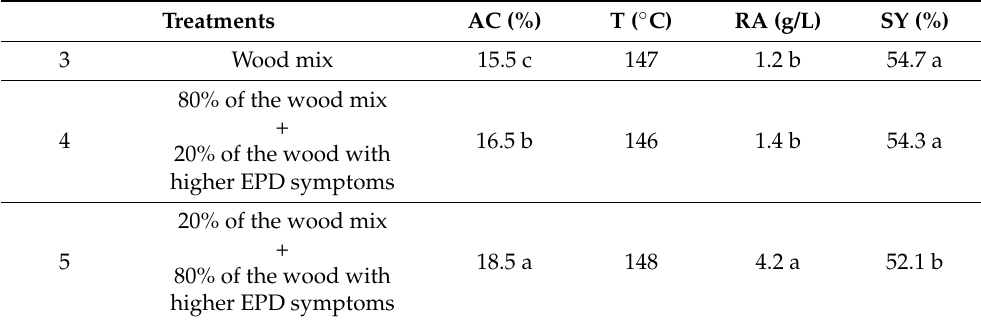
Table 5. Mean values of the wood pulping variables of Eucalyptus grandis × Eucalyptus urophylla under higher stress and a cooking